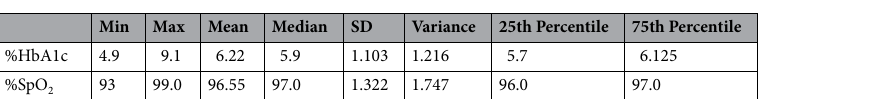
Table 5. Statistics of the measured %HbA1c and %SpO 2